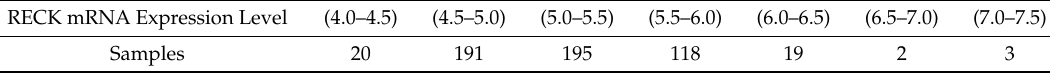
Table 2. RECK mRNA expression data from TCGA data.